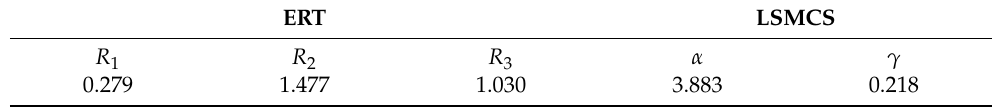
Table 3. Determined model parameters.